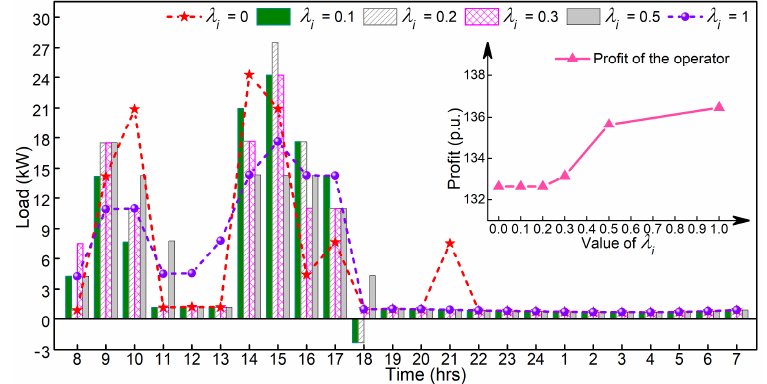
Figure 14. Simulation results of the charging station with different λ i : the load profiles in the big frame demonstrate the load curve changes to be more fluctuate with the increase of λ i ; the profit of the operator in the small frame indicates the profit can be improved with the increase of λ i.